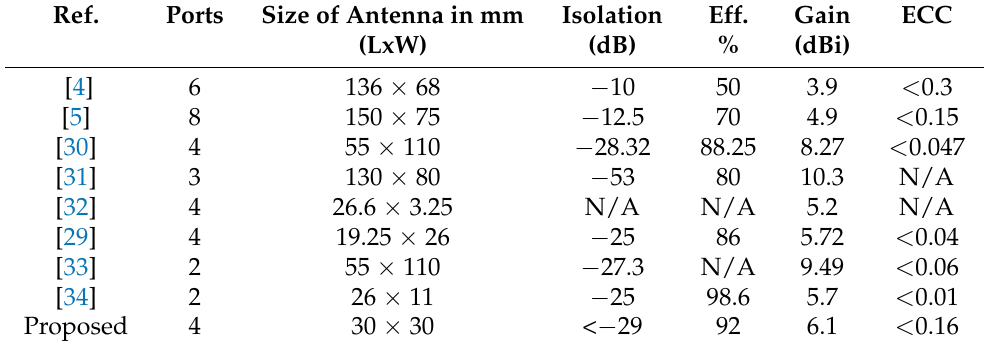
Table 2. Literature Comparison with the proposed MIMO